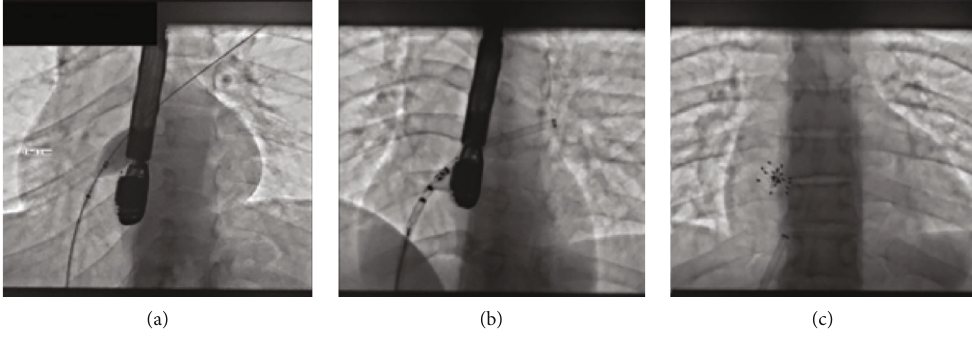
Figure 3: (a – c) Cardia Ultrasept PFO 20mm device